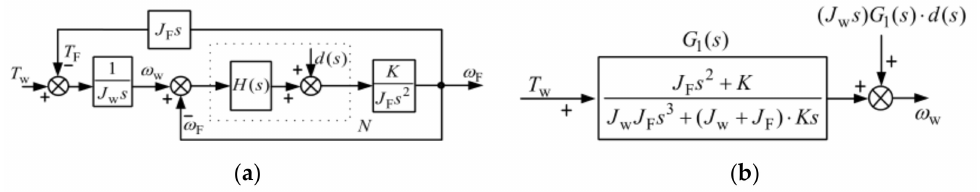
Figure 14. Equivalent structure diagram of the two-mass wind turbine drivetrain of wind turbine ( a ) Equivalent transformation of structure diagram (1); ( b ) Equivalent transformation of structure diagram (2).